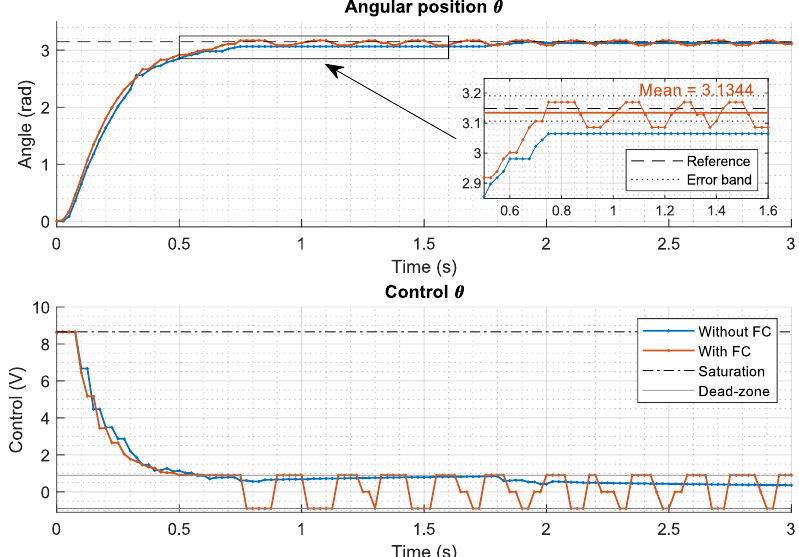
Figure 19. Back-right wheel experimental results with and without friction